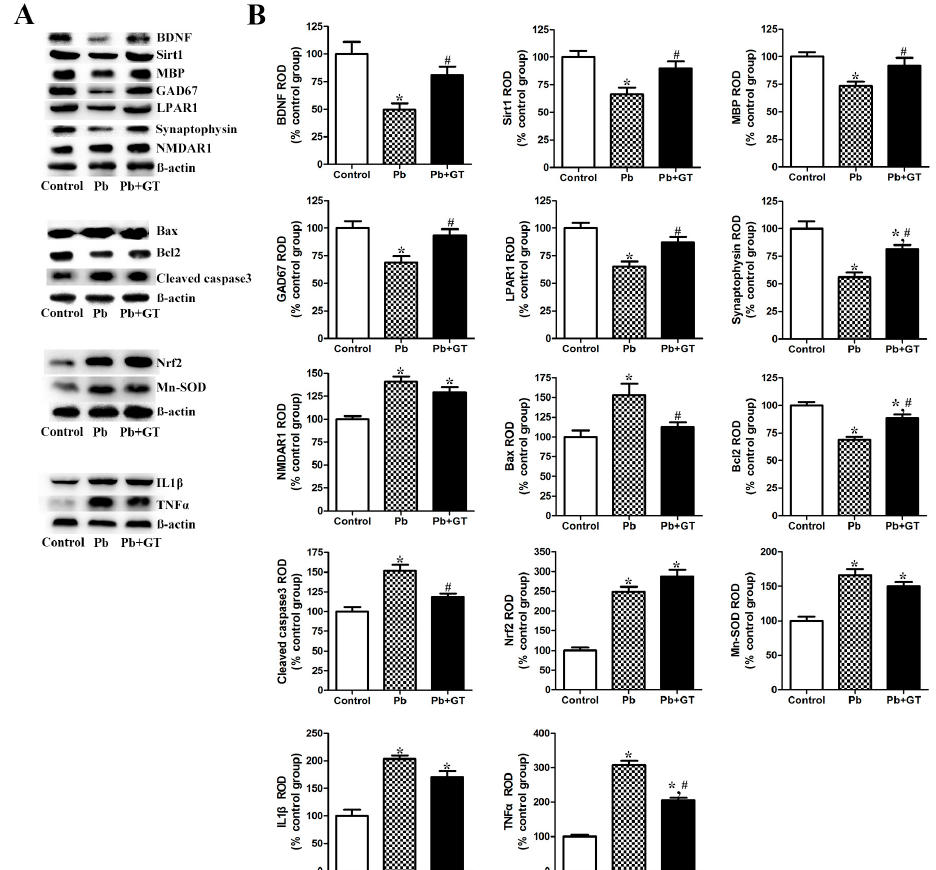
Figure 3. Effects of gintonin on Pb-induced cerebellar changes in various protein expression levels. Representative immunoblots for BDNF, Sirt1, MBP, GAD67, LPAR1, synaptophysin, NMDAR1, Bax, Bcl2, cleaved-caspase3, Nrf2, Mn-SOD, IL-1 β , and TNF α ( A , B ) in the cerebellum of pups